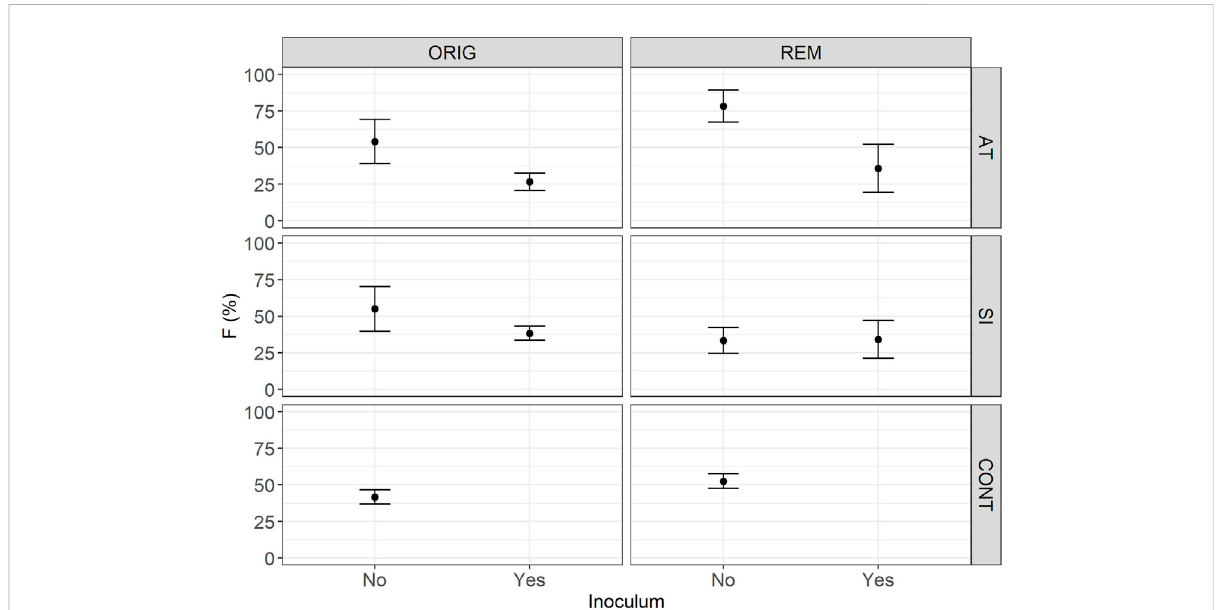
FIGURE 2 Meanrelativefrequency(F)ofplantrootscolonisedwitharbuscularmycorrhizalfungi(F)in Loliumperenne L.inAustrian(AT),Slovenian(SI)and control soil (CONT), before (ORIG) and after remediation (REM). Root sampling on 17 November 2017. The addition of indigenous inoculum (rhizosphere soil and roots from a grassland) is indicated with yes/no. Presented are means ± SE of measured values.